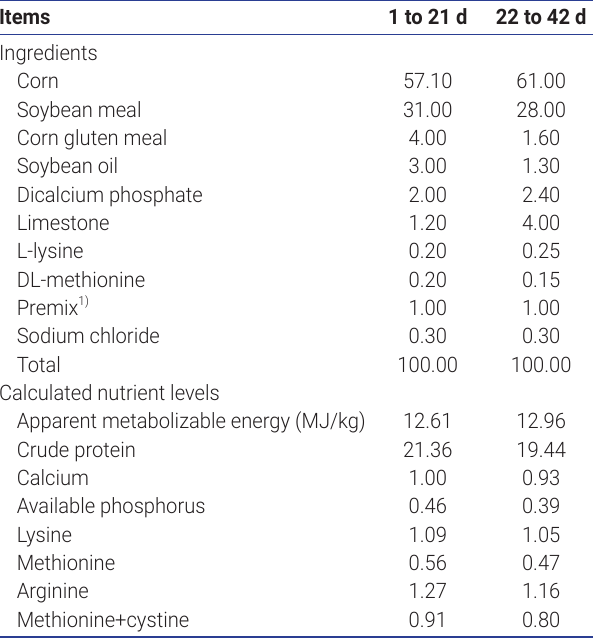
Table 1. Composition and nutrient level of basal diet (as fed basis, %)